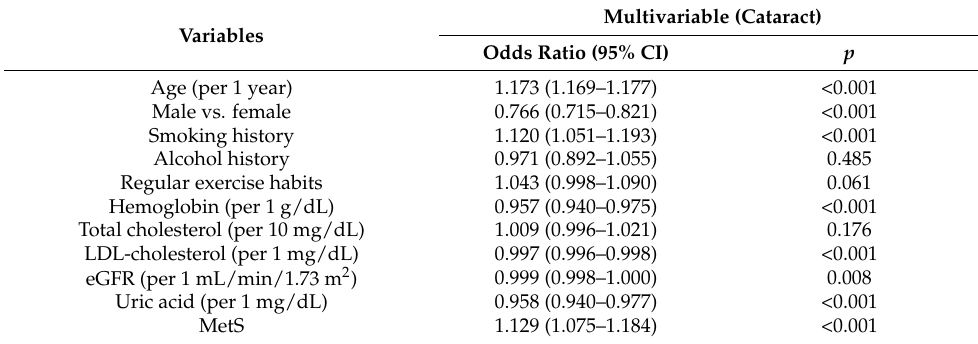
Table 2. Association of MetS and cataract using multivariable logistic regression analysis.